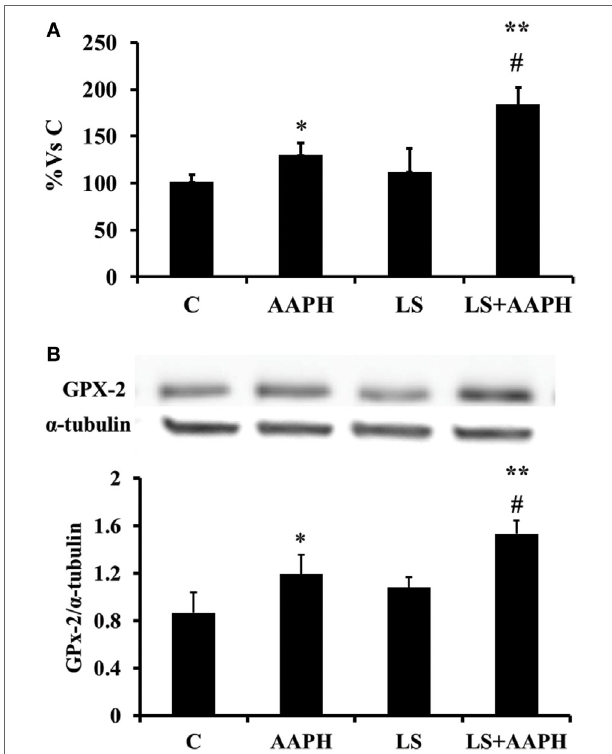
FigUre 5 | Effect of Lactobacillus casei Shirota (LS) on expression of GPX2 in human colon carcinoma cell line/TC7 cells. Gene expression of gastrointestinal glutathione peroxidase was evaluated by real-time PCR. Cells differentiated on transwell filters were untreated (control), treated with AAPH (AAPH) treated with LS (LS) or pretreated with LS for 1.5 h, and then treated with AAPH (LS + AAPH) for 2.5 h. After treatments, the cells were washed and total RNA extracted. Gene expression of GPX2 (a) was performed in technical triplicate and repeated at least three separate times. (Data in figures are expressed in Log 2 in order to provide symmetrical distribution of gene expression effects and reported as percentage of gene expression in control cells). All data are expressed as the ratio to the reference gene Actin. Statistical significance was determined by unpaired Student’s t -test. Differences with P values < 0.05 were considered significant and indicated within each parameter by * P < 0.05 vs C, ** P < 0.01 vs C, and # P < 0.01 vs AAPH. Protein expression was evaluated by Western Blot (B) . Cells differentiated on transwell filters were untreated (control), treated with AAPH (AAPH) treated with LS or pretreated with LS for 1.5 h, and then treated with AAPH (LS + AAPH) for 2.5 h. After the treatments, the cells were lysed and fractionated by SDS-PAGE and transferred to nitrocellulose filters. The membranes were incubated with rabbit anti-gastro-intestinal glutathione peroxidase and anti- α -tubulin primary antibodies, and then with horseradish peroxidase-conjugated secondary antibodies. The figure shows a representative Western blot of GPX2 (upper panel) and the densitometric values of the immunoreactive protein bands (lower panel). The relative expression levels of GPX2 were normalized to α -tubulin levels. Values represent mean ± SD of at least three independent experiments, carried out in triplicate. Differences with P values < 0.05 were considered significant and indicated within each parameter by * P < 0.05 vs C, ** P < 0.01 vs C, and # P < 0.01 vs